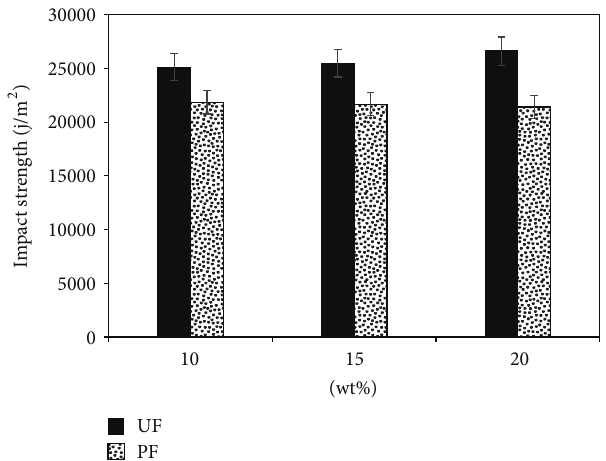
Figure 7: Impact strength of sago particleboard versus resin matrix content (wt%).